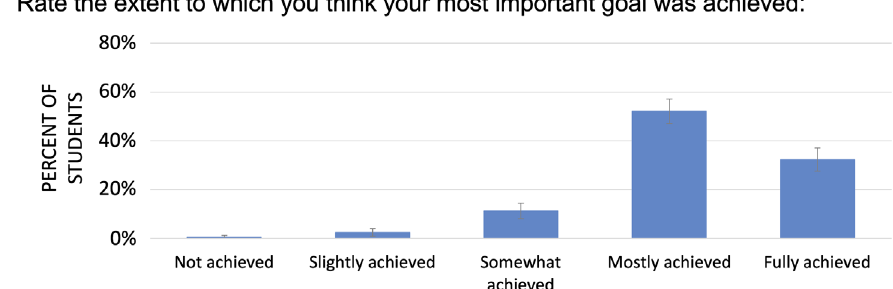
FIG. 6. Student responses ranking achievement of their previously indicated most important goal this semester. Uncertainties are calculated using the binomial confidence interval with α ¼ 95% .